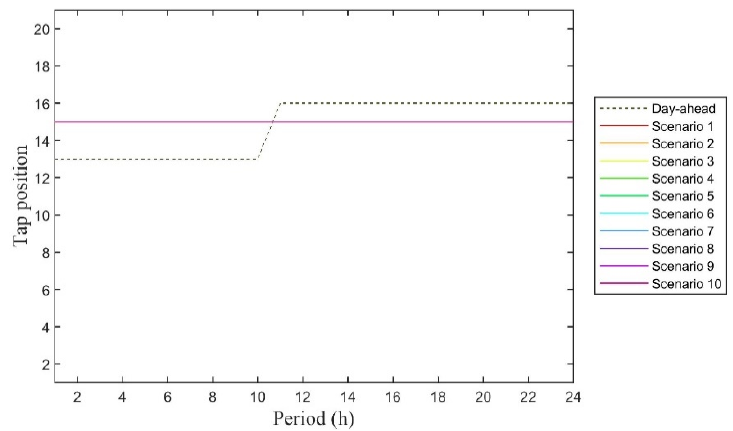
Figure 8. Transformer 1 with OLTC ability throughout 24 hours.